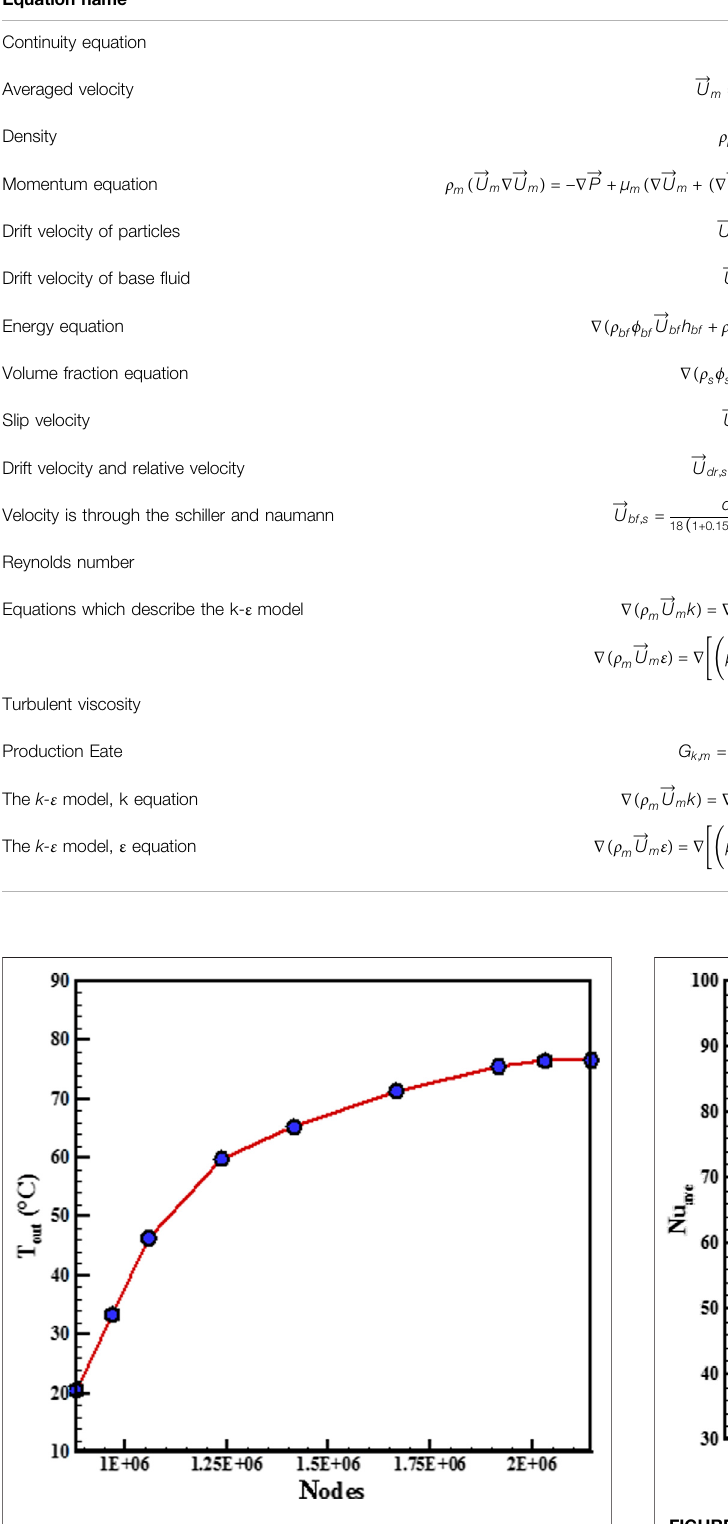
Frontiers in Energy Research |